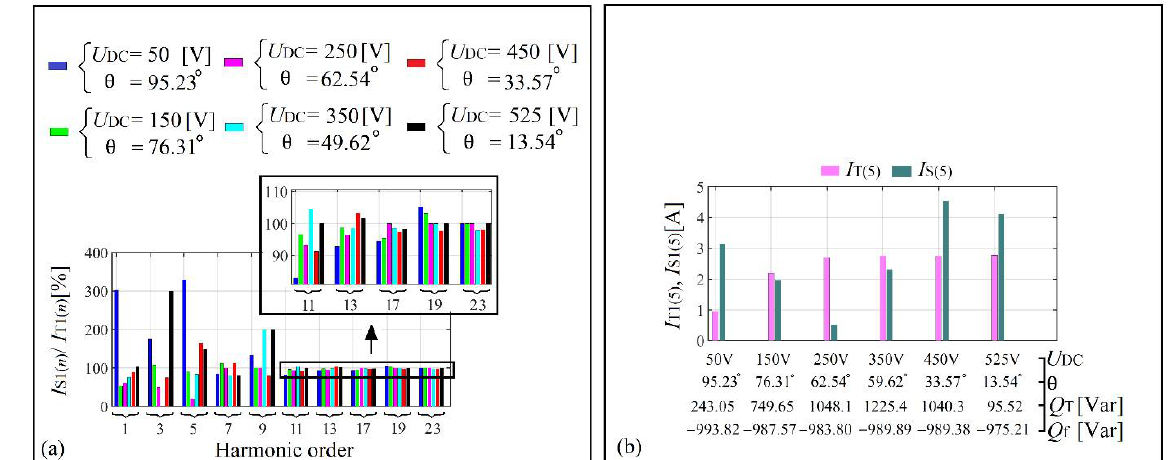
Figure 20. ( a ) Single-tuned filter work efficiency, ( b ) the 5th harmonic current amplitude generated by the load ( I T(5) ) is compared to the 5th harmonic current amplitude at the grid side ( I S(5) ) for different firing angle.